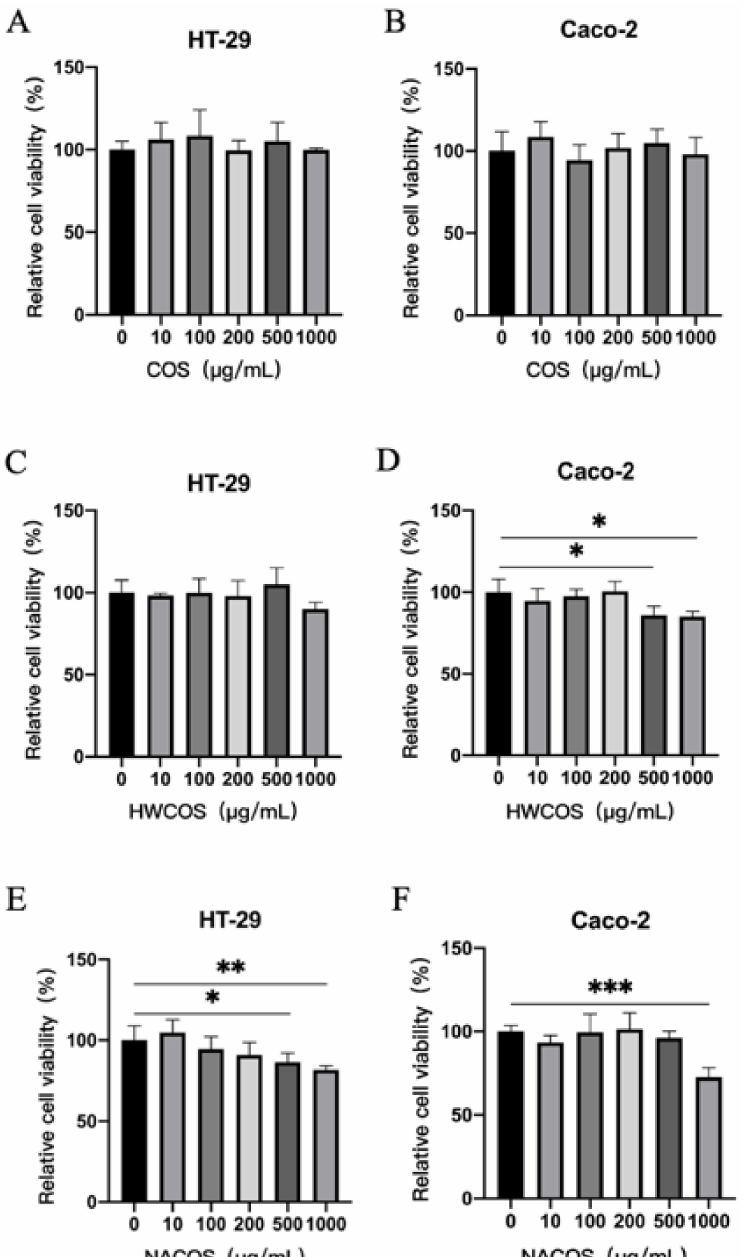
Figure 4. Cell viability after COS, HWCOS, and NACOS treatment in HT-29 and Caco-2 cells. Cells were treated with different concentrations (10, 100, 200, 500, 1000 µ g/mL) of COS, HWCOS, and NACOS for 24 h. After 24 h of incubation, an 3-(4,5-dimethylthiazol-2-yl)-2,5-diphenyltetrazolium bromide (MTT) assay was performed to measure the HT-29 cell viability of COS ( A ), HWCOS ( C ), and NACOS ( E ), and the Caco-2 cell viability of COS ( B ), HWCOS ( D ), and NACOS ( F ). The average value of the data was calculated ( n = 5; * p < 0.05, ** p < 0.01, *** p < 0.001). Error bar represents the standard deviation. Data represent the typical situation of three independent